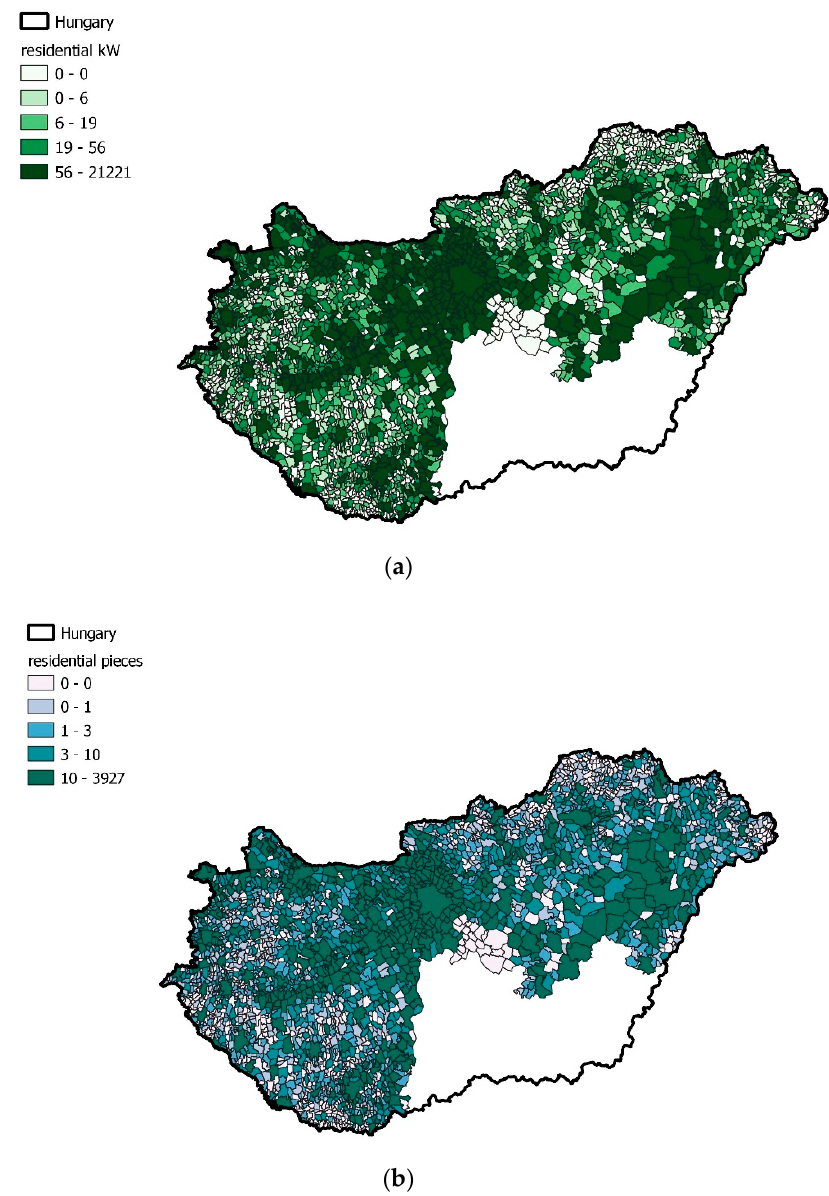
Figure 4. Total residential HMKE power ( a ) and the number ( b ) of residential HMKEs in the settlements of Hungary.